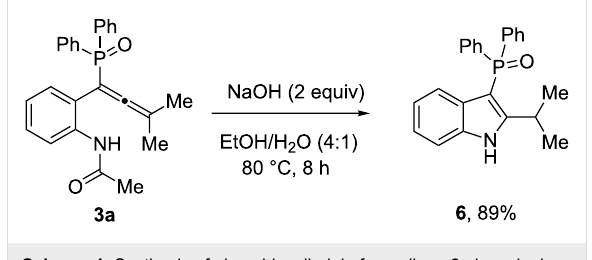
Scheme 4: Synthesis of phosphinoylindole from allene 3a in a single